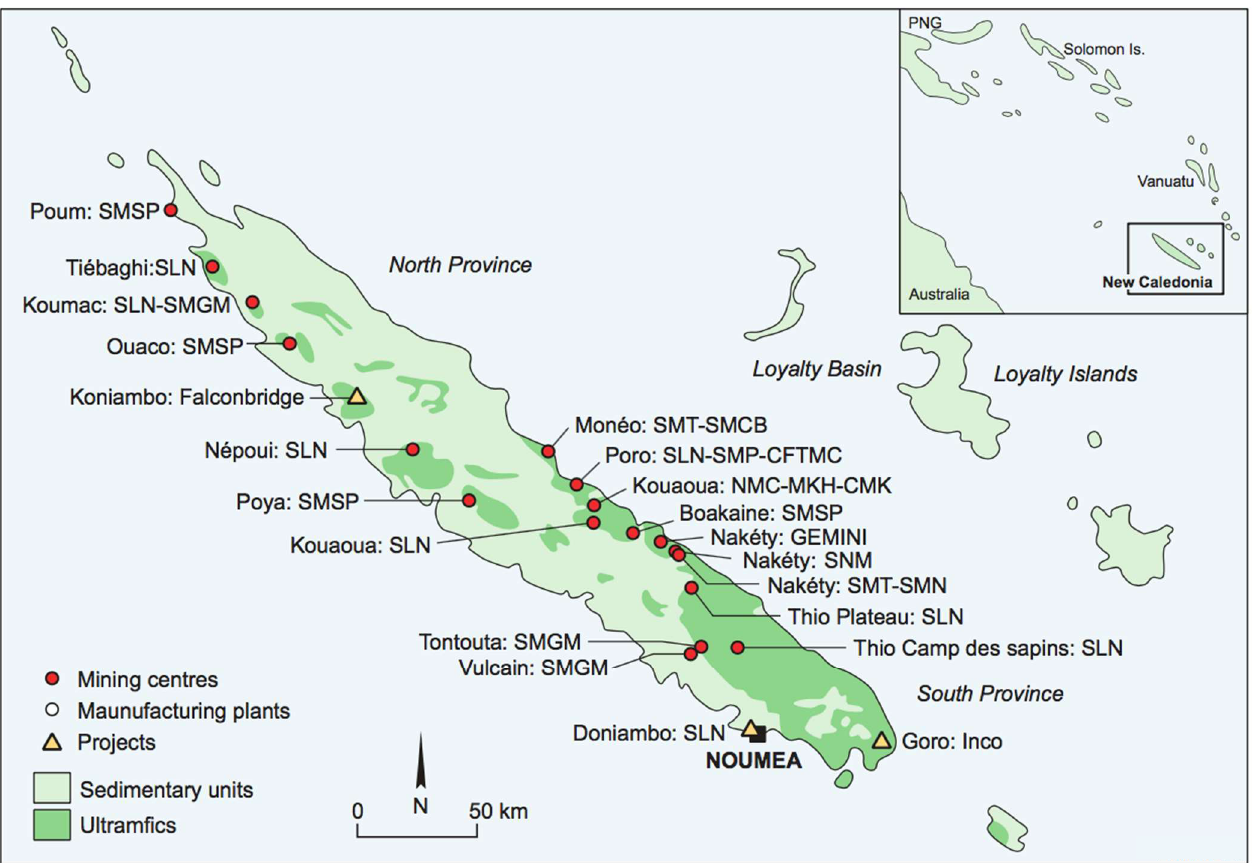
Figure 1. Location of the peridotites and the nickel deposits of New Caledonia [20].